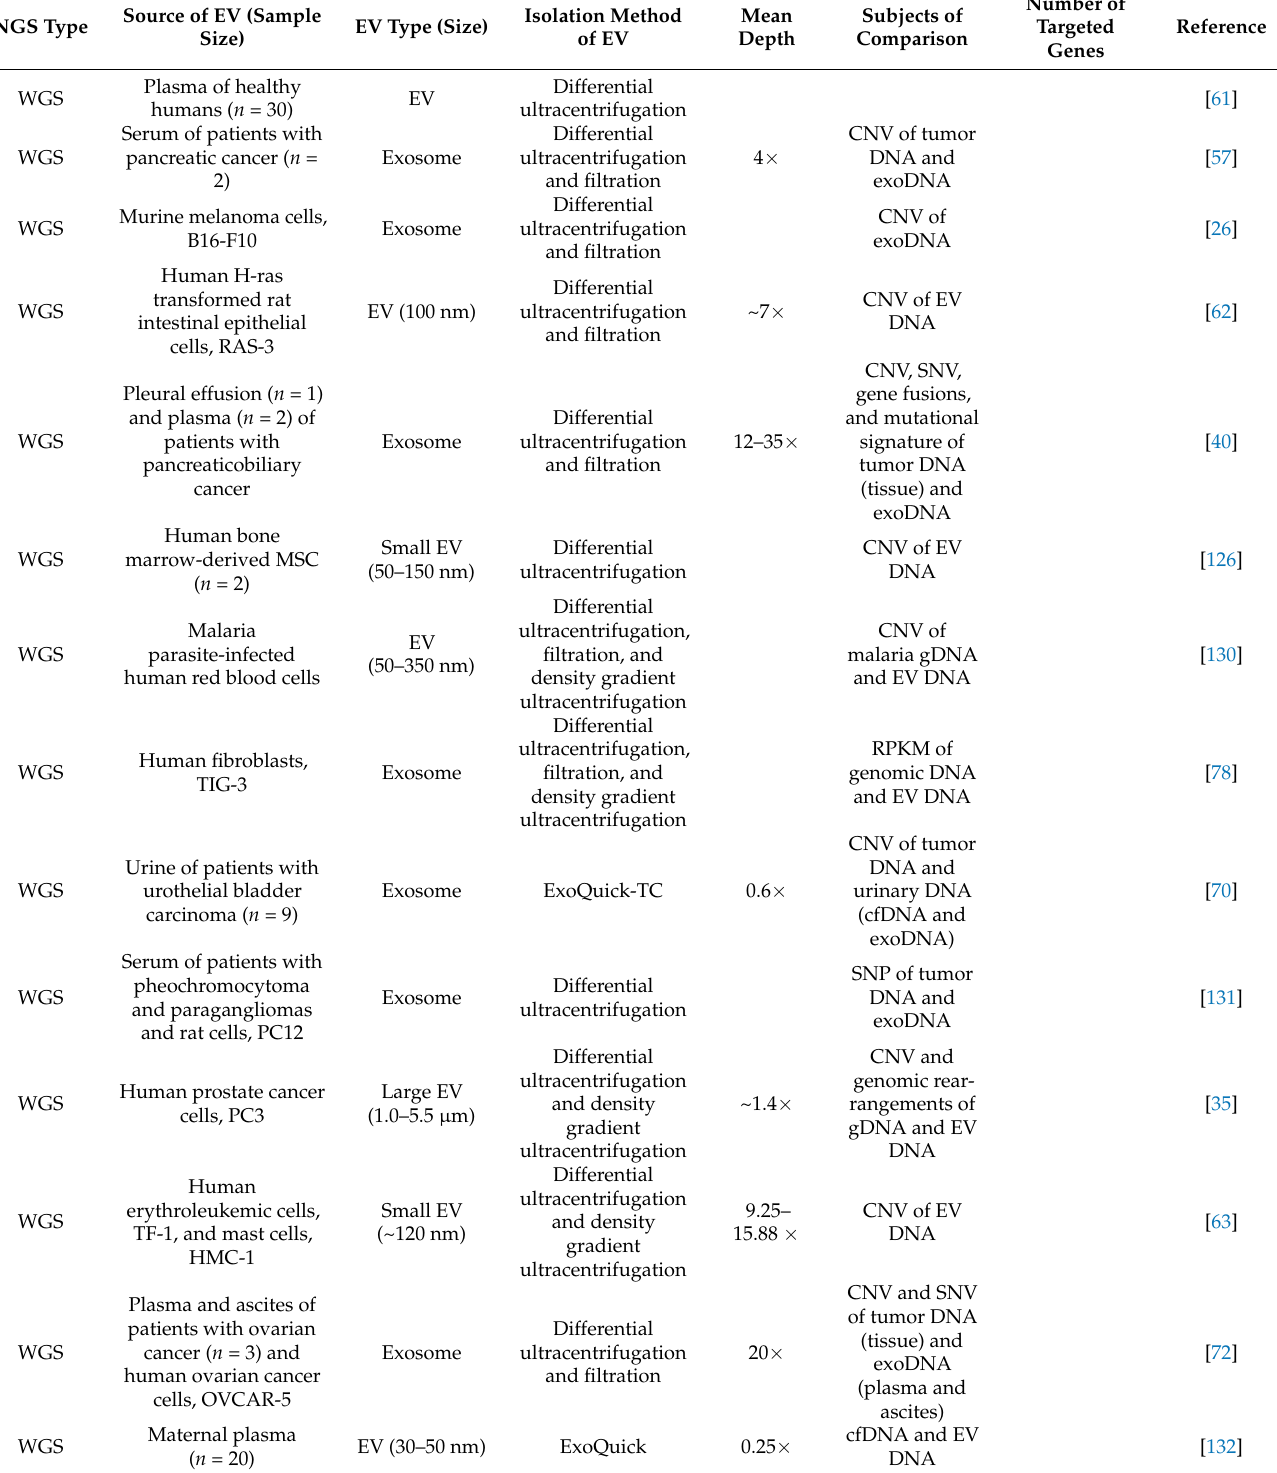
Table 3. Summary of NGS analysis performed with EV